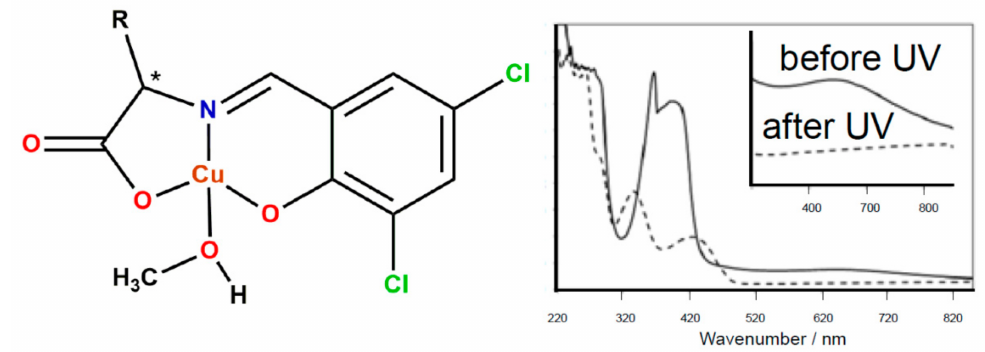
Figure 1. Schiff base Cu(II) complex (* denotes an asymmetric carbon atom) reduced in the presence of TiO 2 after UV light irradiation and UV-Vis spectral changes associated with d-d transition of Cu(II) species before and after UV light irradiation